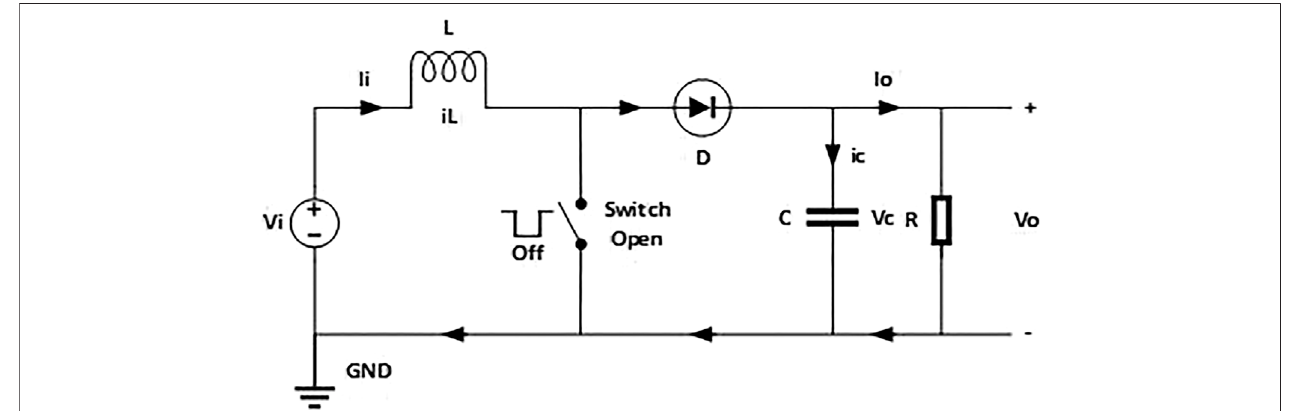
FIGURE 4 | Circuit of DC-DC in open-switch